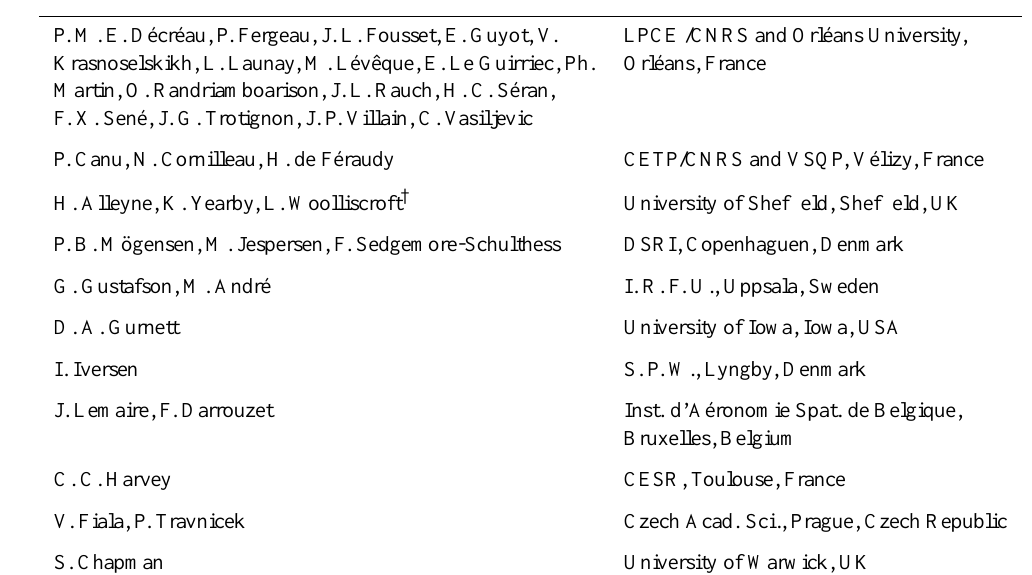
Table 1. The Whisper experimenters